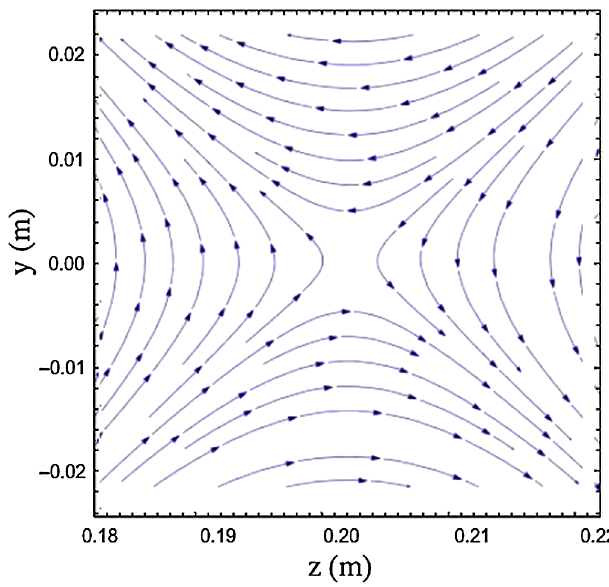
FIG. 7. Magnetic field lines in the y - z plane in the vicinity of the field null, which is at z ¼ 0 : 2 m . x ¼ 0